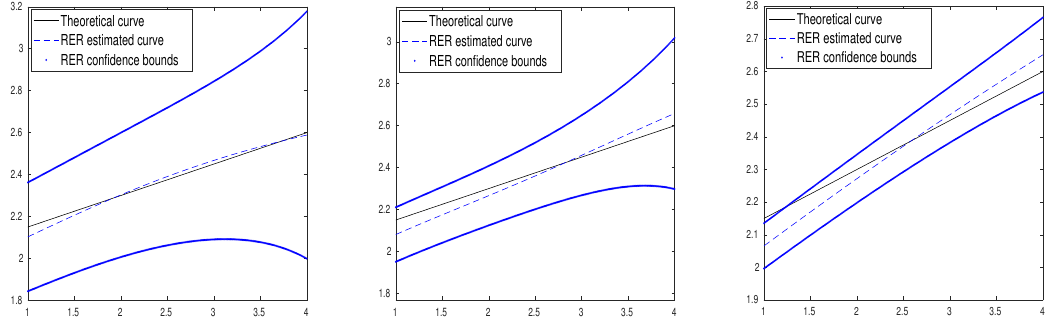
Figure 7: ρ 1 = 0.3 and CR ≈ 25% for n = 50, 200 and 400